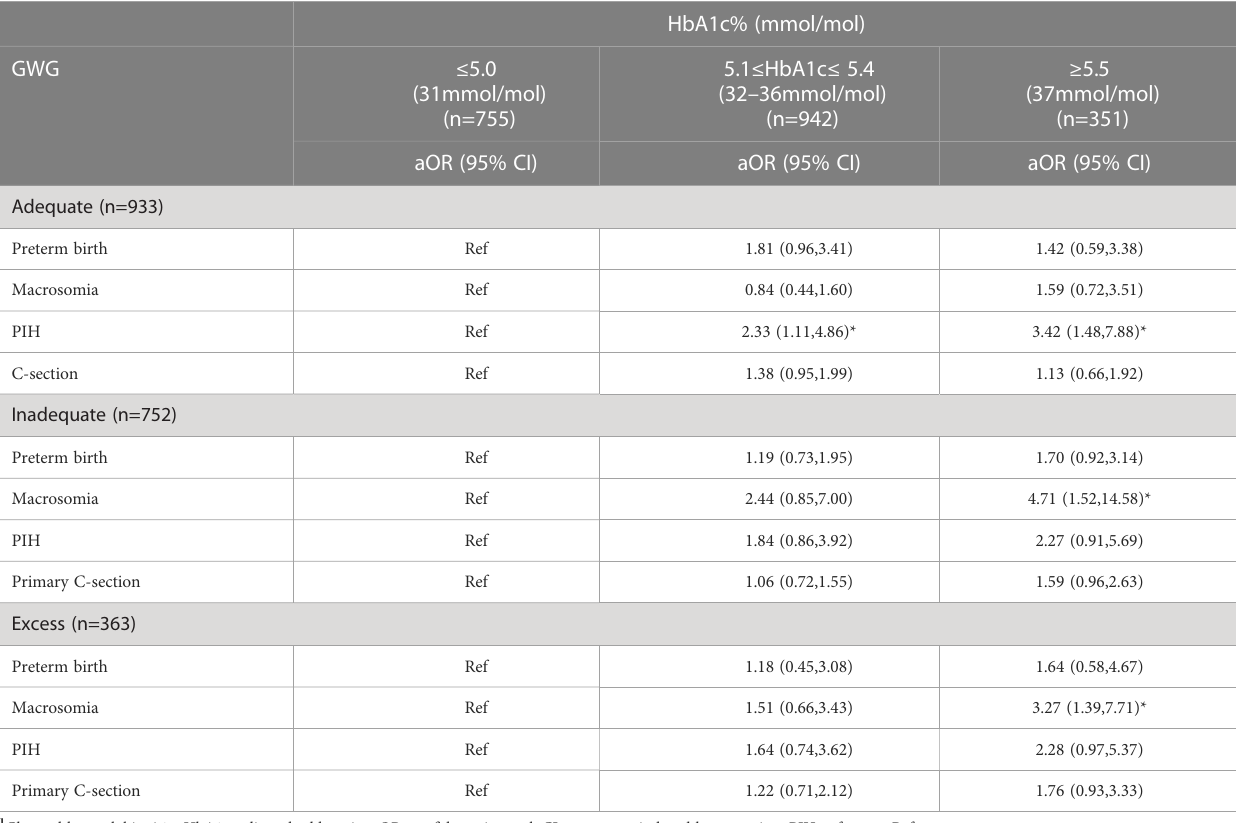
TABLE 5 Association between HbA1c and adverse outcomes in different GWG